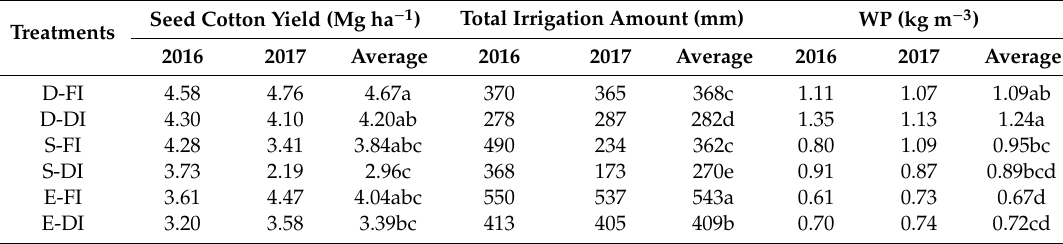
Table 3. Crop yield, total irrigation amount, and WP under di ff erent irrigation treatments.